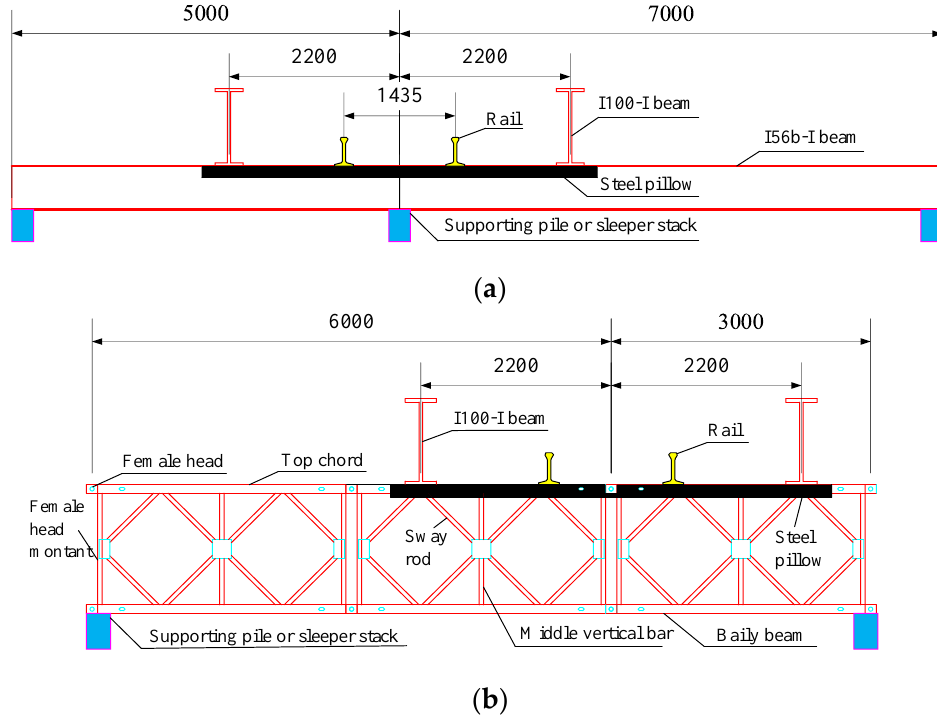
Figure 1. Cross-section of an overhead system (unit: mm): ( a ) Cross-section of type I overhead system. ( b ) Cross-section of type II overhead system.